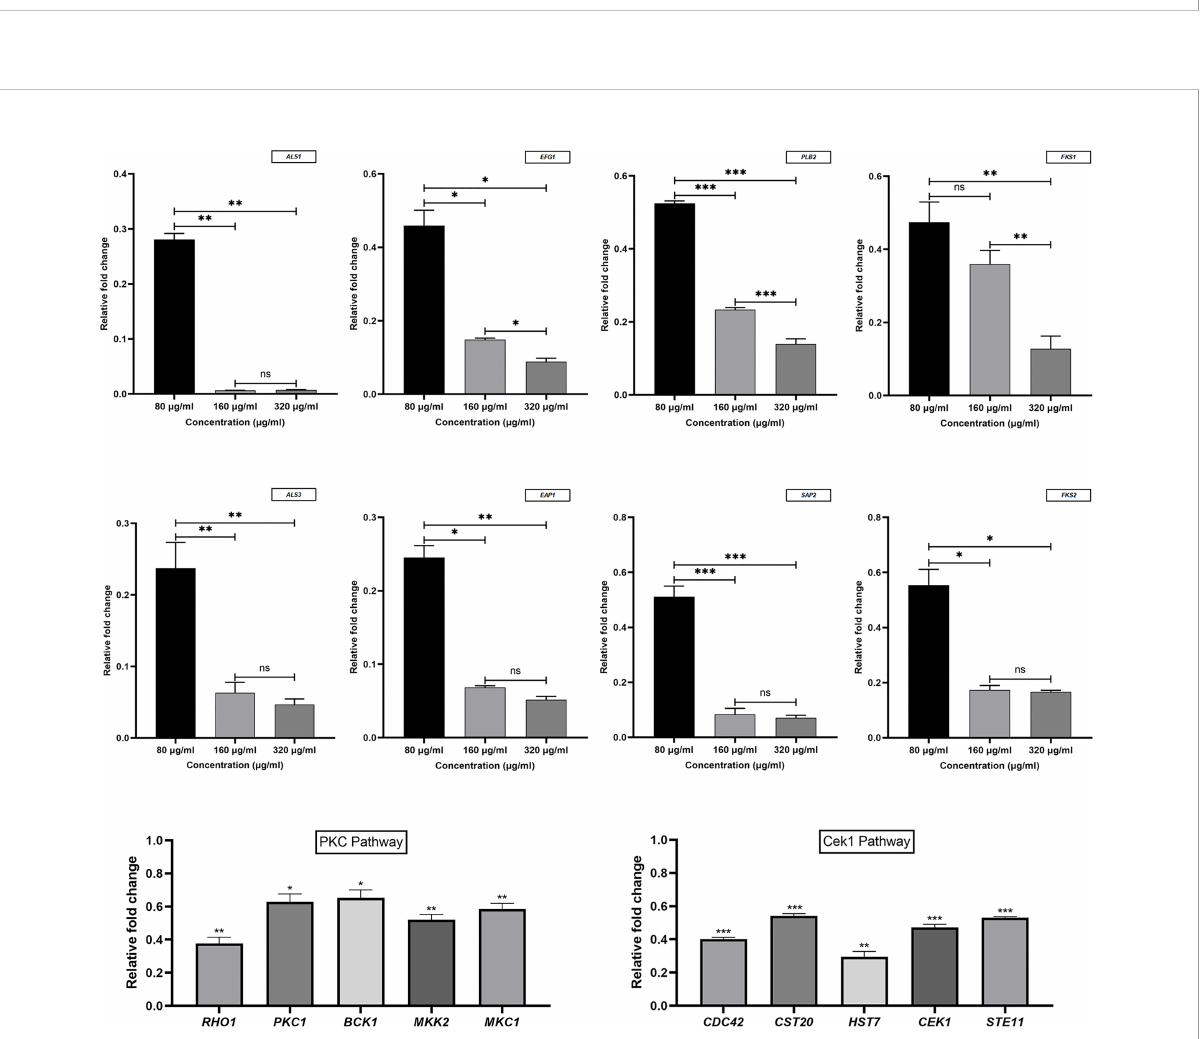
FIGURE 6 Virulence factors and signaling pathway-related genes of C. albicans were measured using qRT-PCR and normalized to the expression of 18S rRNA. Magnolol downregulated the expression of the genes ALS1 , ALS3 , EFG1 , EAP1 , PLB2 , SAP2 , FKS1 , FKS2 , RHO1 , PKC1 , BCK1 , MKK2 , MKC1 , CDC42 , CST20 , STE11, HST7 , and CEK1 . *, P < 0.05; **, P < 0.01; ***, P < 0.001; ns, no signi fi